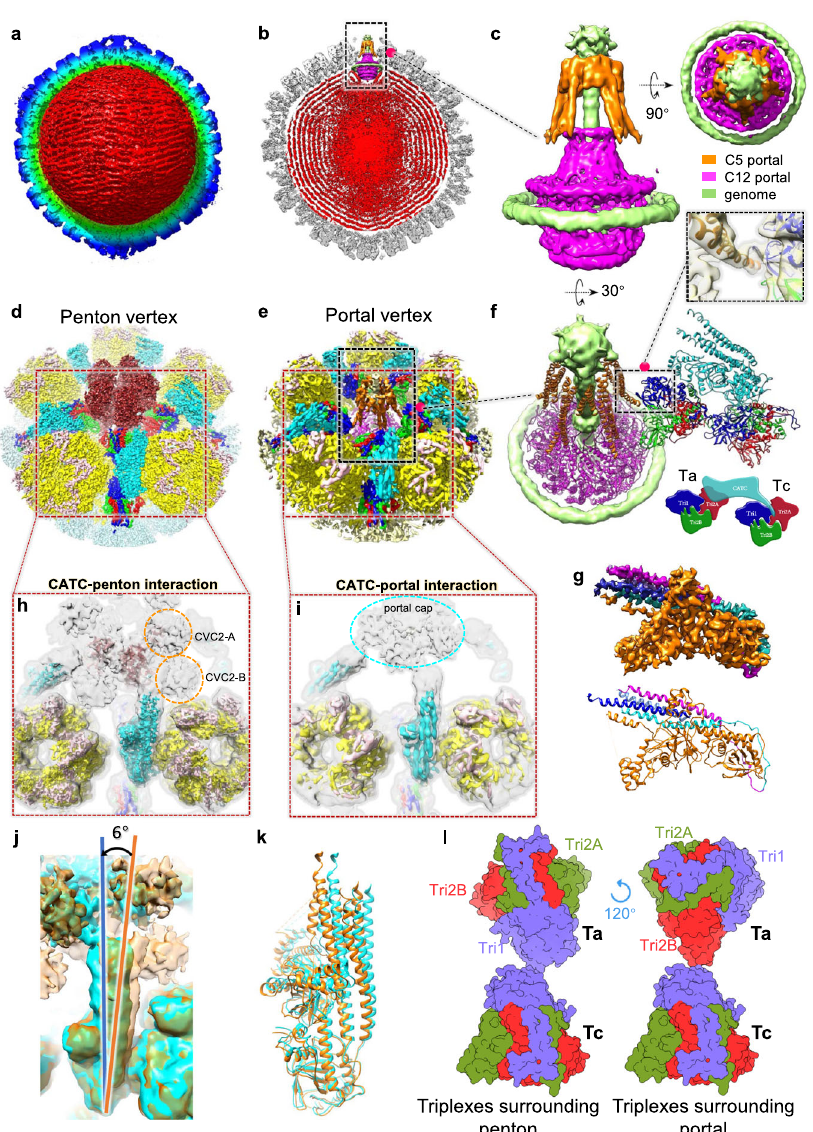
Fig. 6 Architecture of the PRV C-capsid with portal and CATCs. a The unsharpened C5 reconstructed maps of the PRV C-capsid is presented showing a cropped view of the interior density. b , c Clipped ( b ) and zoomed-in ( c ) views of the C5 capsid reconstruction showing packaged double-stranded (ds) DNA within the capsid ( b ) and structural components around the portal vertex ( c ). d , e Sub-particle reconstructions of the penton vertex ( d ) and the portal vertex ( e ). f Rotated view of ( c ) with a fi tted model of the C5 portal protein (helix bundle) and the C12 portal protein. This view shows the interactions between the portal proteins and CATCs and triplexes beneath. g Segmented density map of the CATCs and the corresponding model. h Penton vertex sub- particle reconstruction. The CATC helix bundle is near two densities (orange circles), which are likely the head domains of capsid vertex component 2 (CVC2)-A and CVC2-B. i Portal vertex reconstruction. The CATC helix bundle is connected to the portal cap (cyan circle). j , k Comparisons of maps ( j ) and corresponding models ( k ) of CATCs from the penton and portal vertices. There is a counterclockwise (6°) rotation of the CATCs when bound to the portal vertex. l Comparison of triplexes: Ta in external orientation relative to Tc in the penton and portal vertexes. Ta in the penton vertex rotates 120° counterclockwise around its apical domain. Abbreviations: CATC Capsid-associated tegument complex; MCP Major capsid protein; SCP Small capsid protein; Tri